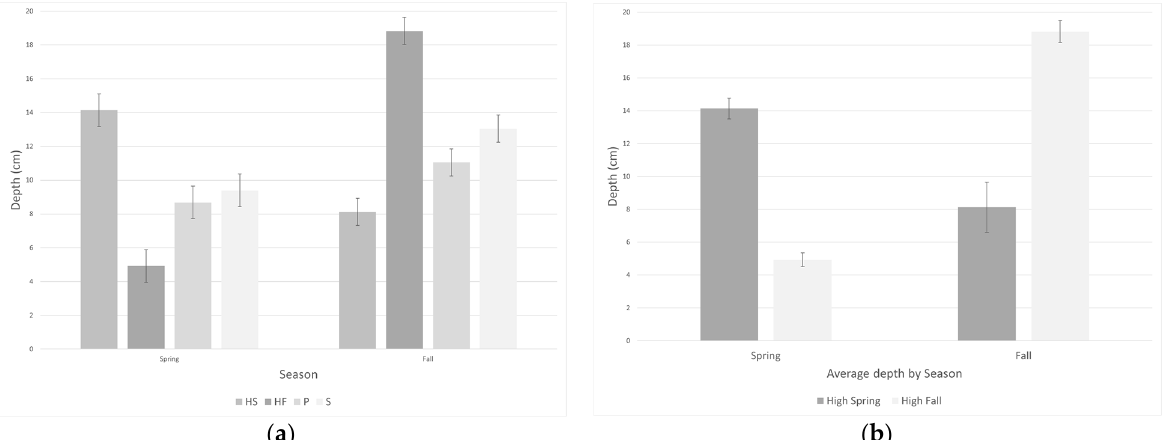
Figure 2. Average water depth (±standard error) in 2008 by mesocosm type: ( a ) by hydrologic regime and season; ( b ) by season for high spring and high fall.